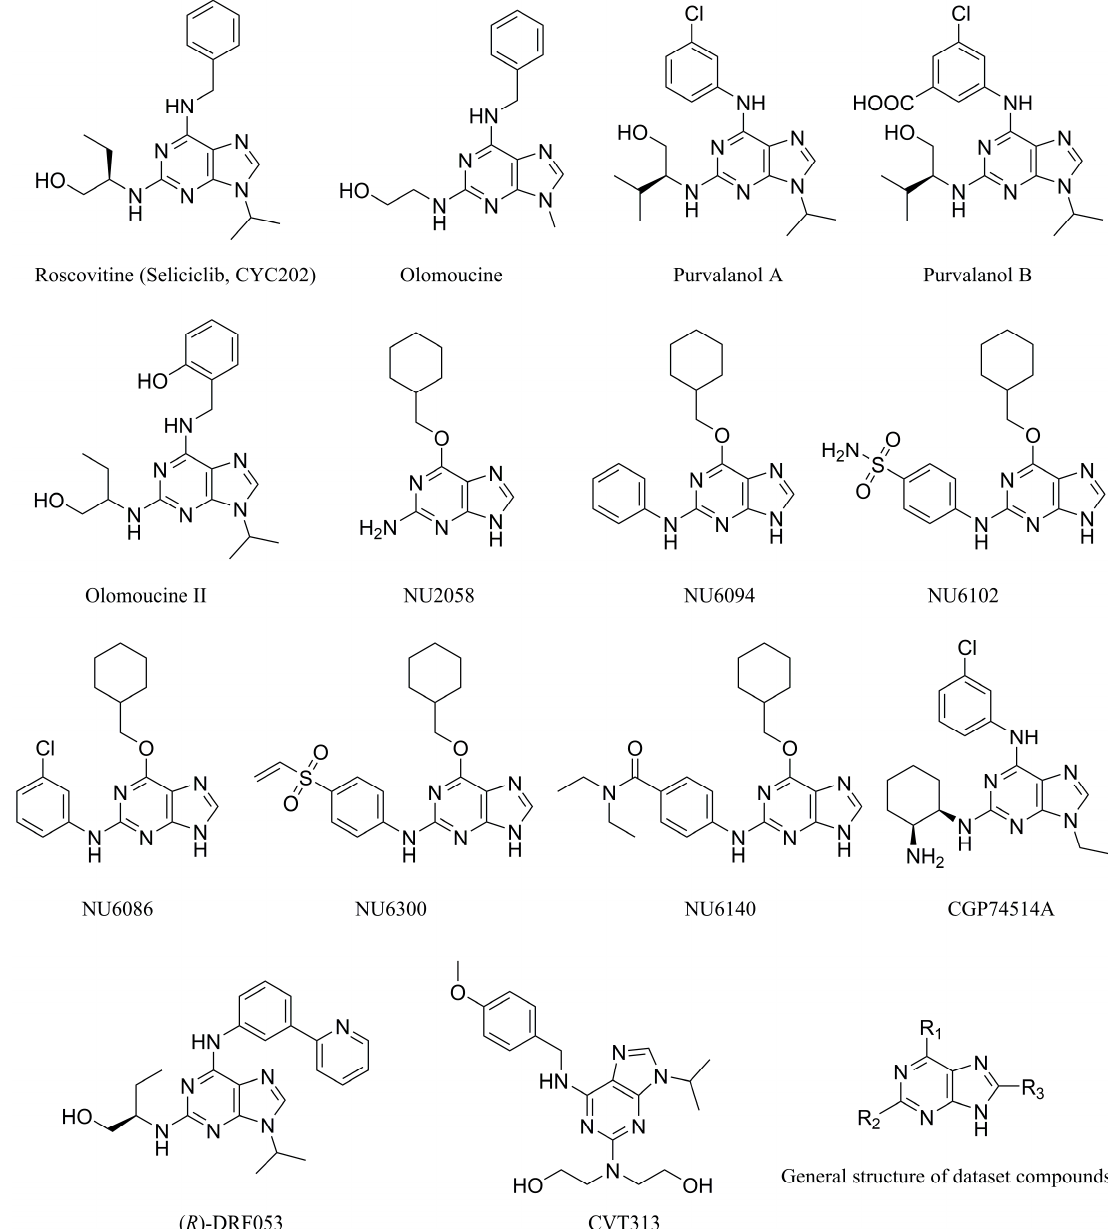
Figure 2. The structures of some CDK inhibitors have the purine scaffold and the general structure of the compounds studied here.